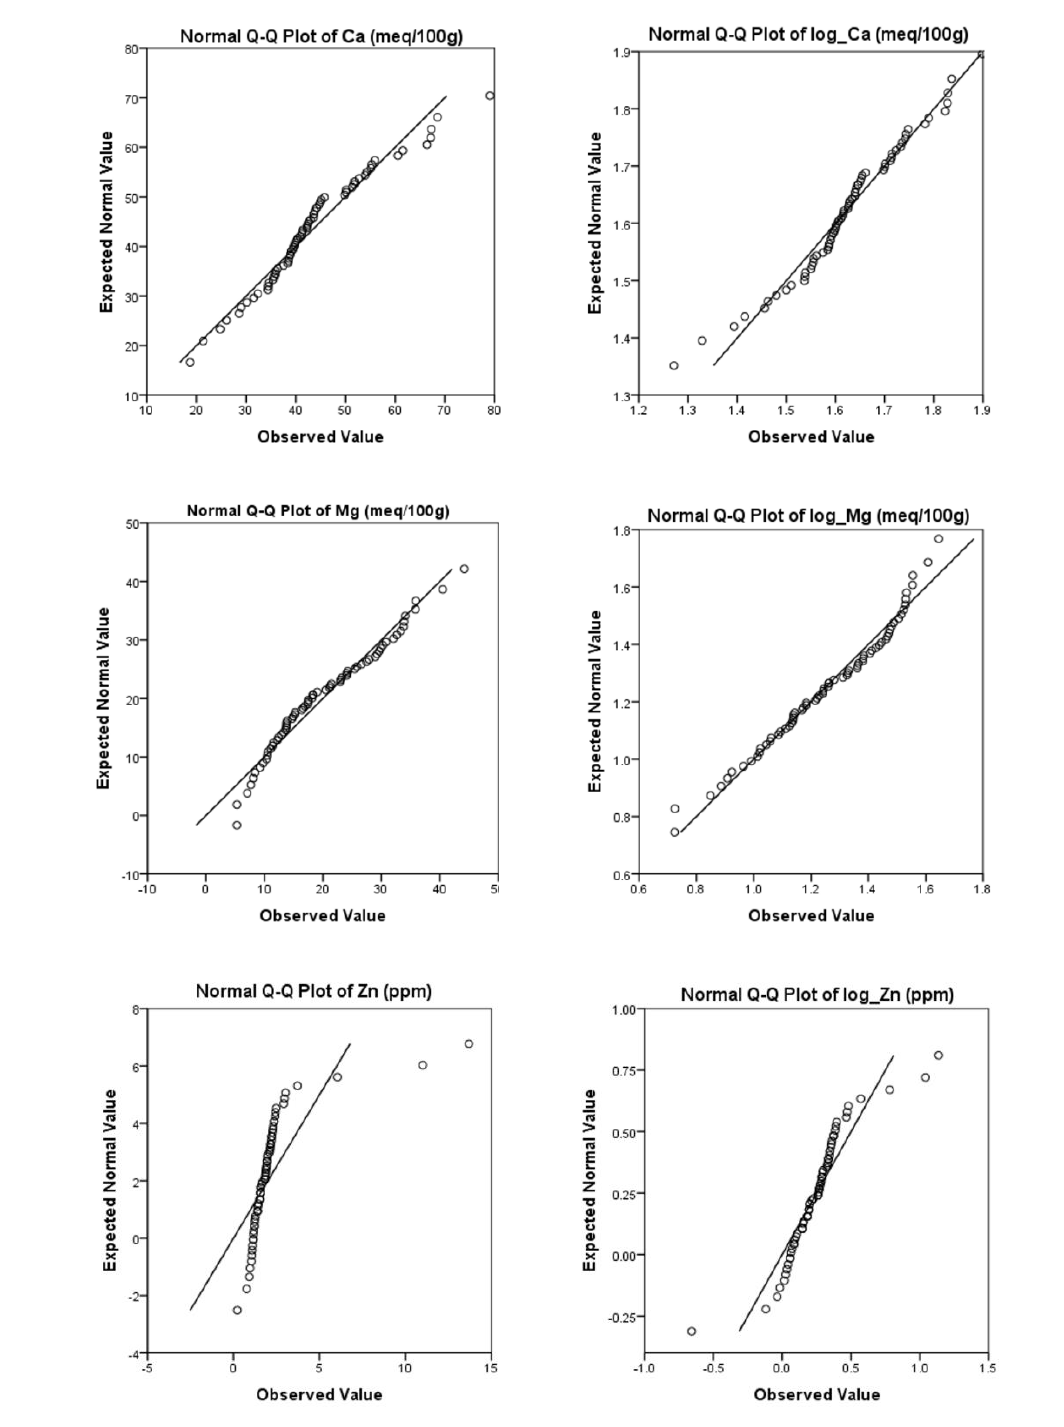
Figure 3. Q-Q plots for Ca, Mg, and